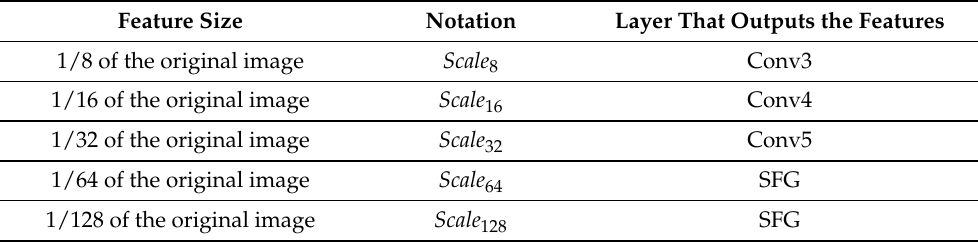
Figure 2. The process of generating multiscale features. Table 1. Definition of Multi-scale